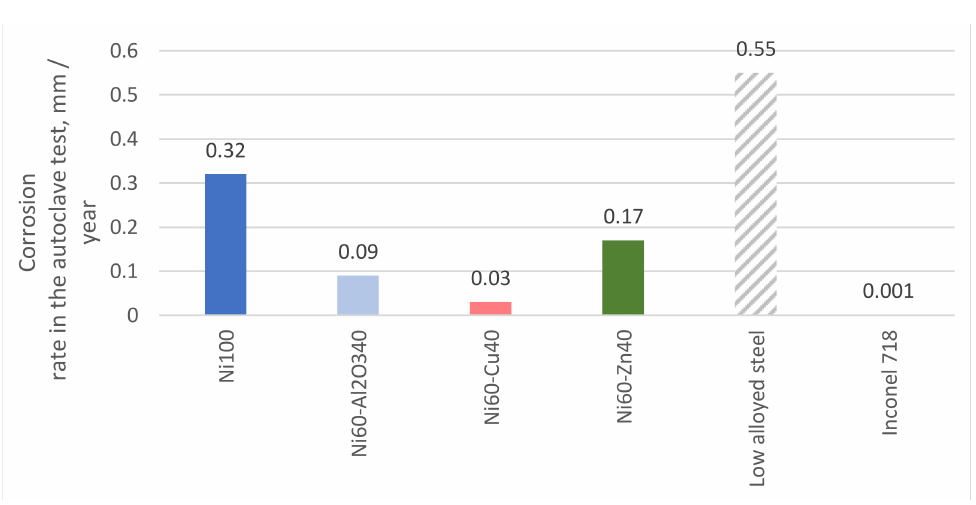
Figure 10. The corrosion rate of the nickel coatings in the autoclave test in 5.0 wt.% NaCl solution saturated with hydrogen sulfide (P H2S = 1 MPa) and nitrogen (P N2 = 5 MPa) at a temperature of +80 ◦ C with pH = 3.5